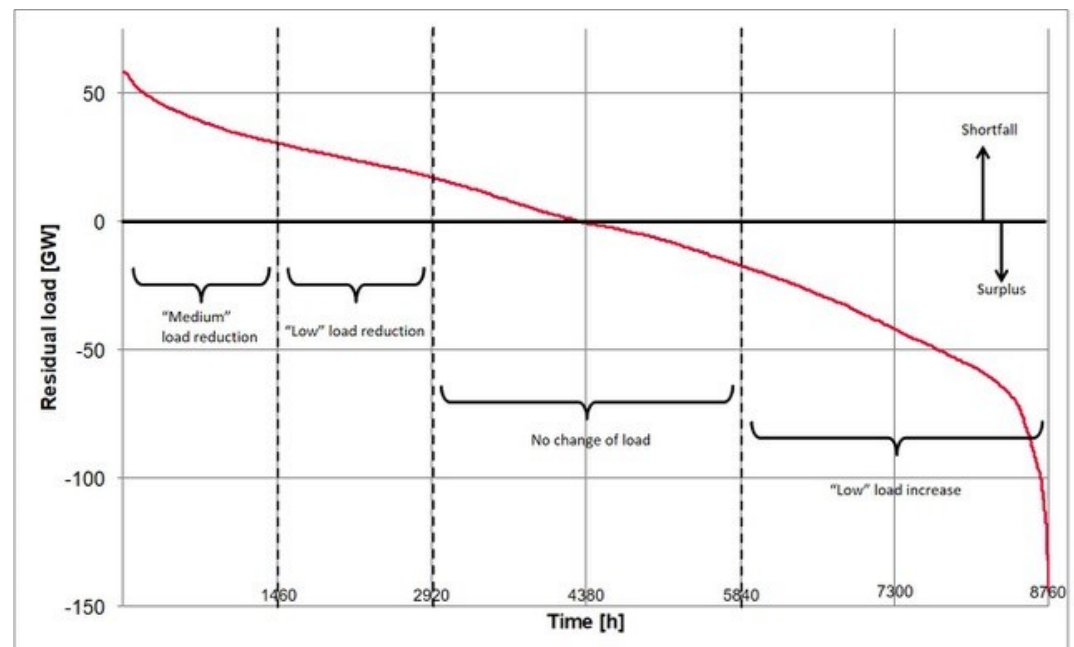
Figure 1. Assumed residual load of German electrical grid for a